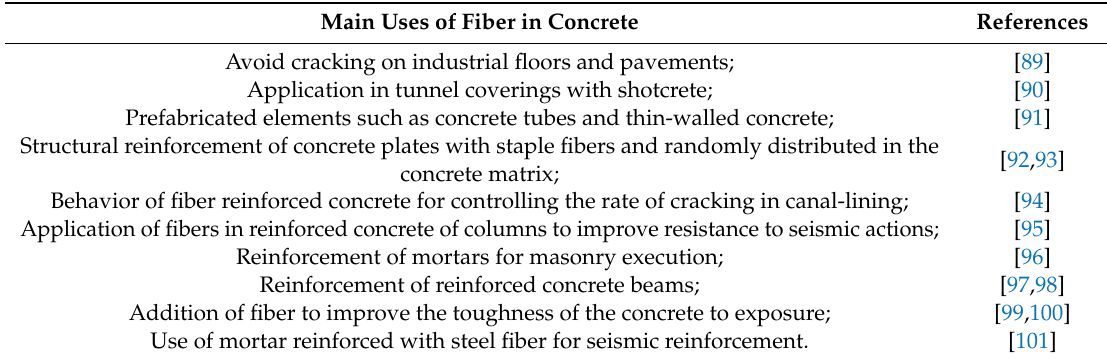
Table 1. Some fiber concrete